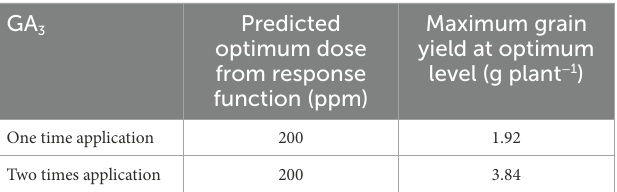
TABLE 7 The impact of different doses of GA 3 applied at varying frequencies on grain yield of mungbean. GA Predicted 3 optimum dose from response function (ppm)